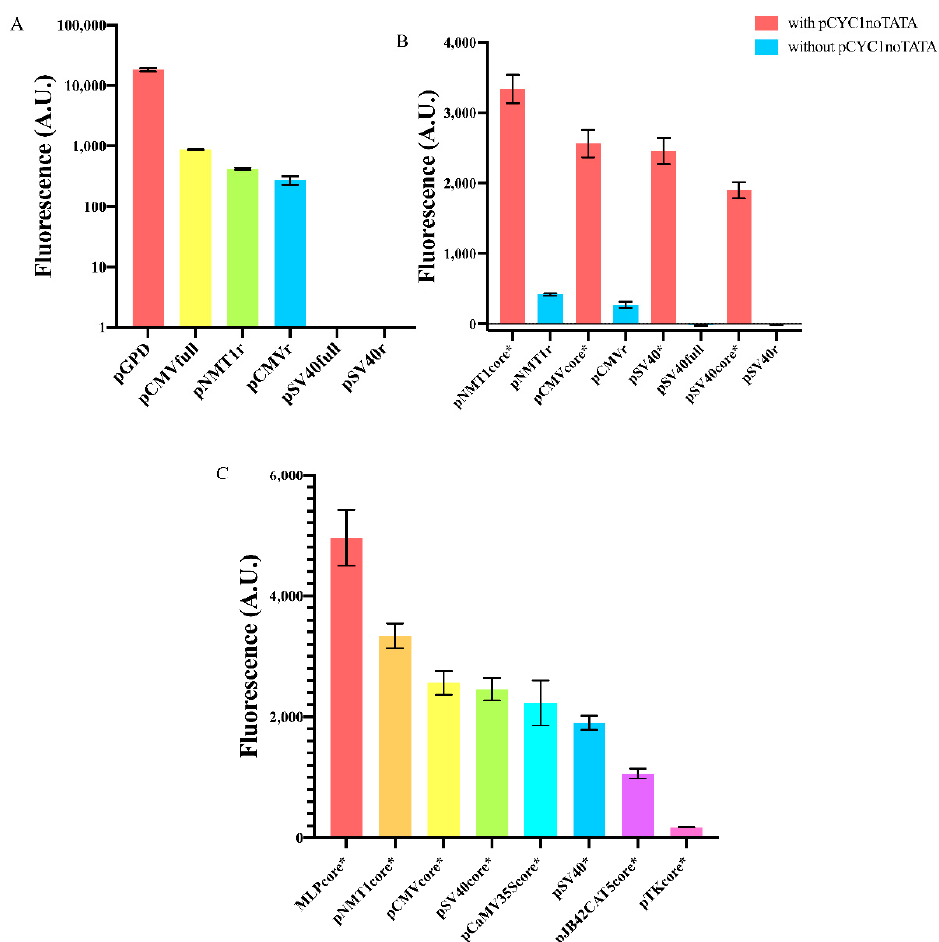
Figure 2. Fluorescence expression from foreign promoters and yeast synthetic core promoters. ( A ) Full or reduced foreign promoter sequences appear either unfunctional (pSV40full, pSV40r) or extremely weak if compared to the strong yeast constitutive GPD promoter. Fluorescence intensity, on the y-axis, is represented in a logarithmic scale and expressed in arbitrary units (AU). ( B ) Synthetic core promoters constructed by extending foreign promoters with pCYC1noTATA show a dramatic enhancement in fluorescence expression. ( C ) Comparison of the mean fluorescence expressed by our eight new synthetic core promoters. Each mean fluorescence value comes from three independent experiments.